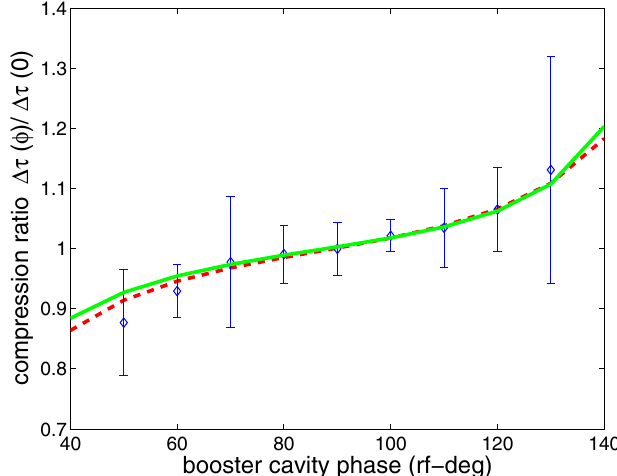
FIG. 5. (Color) Compression factor in the booster cavity for various operating phases. Diamonds are experimental measure- ments, solid and dashed lines correspond, respectively, to ana- lytical calculation using Eq. (6), and numerical simulations performed with ASTRA . Note: The phase to maximum